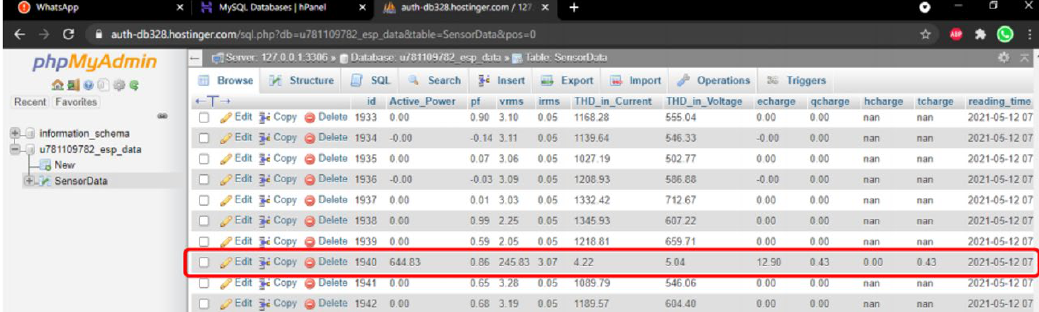
Figure 17. The SQL database and visualization on the website.